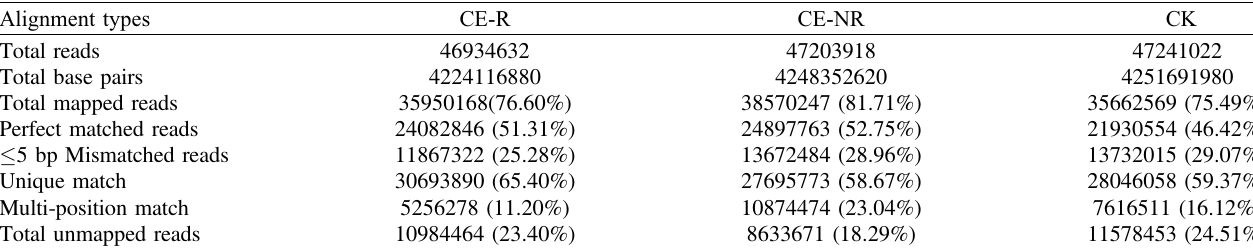
Table 2. Alignment statistics of reads and reference